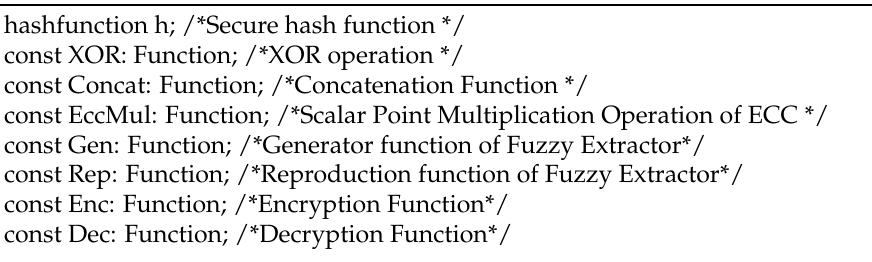
Table 10. Specification of the proposed protocol in